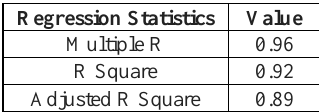
Table 1: Showing the predicted biomass using the TLS modelled volume equation and field observed biomass for all the 13 plots. The regression statistics of the TLS modelled volume equation is represented in Table 2. Where, the multiple R is obtained as 0.98. The R 2 obtained was 0.92, the adjusted R2 was reported as 0.89. The standard error was observed as 0.049. Considering the R 2 value of the multiple regression analysis, the importance of the radius and height for the estimation of stem volume is shown. The correlation between the independent (radius and height) variables and dependent (volume) variable is very high and hence, can be used for the calculation of stem volume.